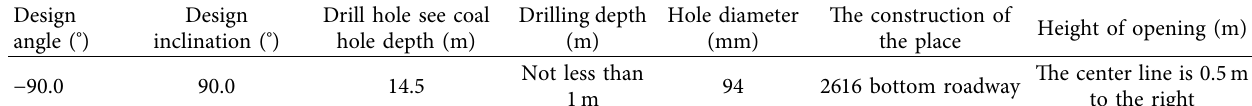
Table 10: Parameters of extraction borehole.